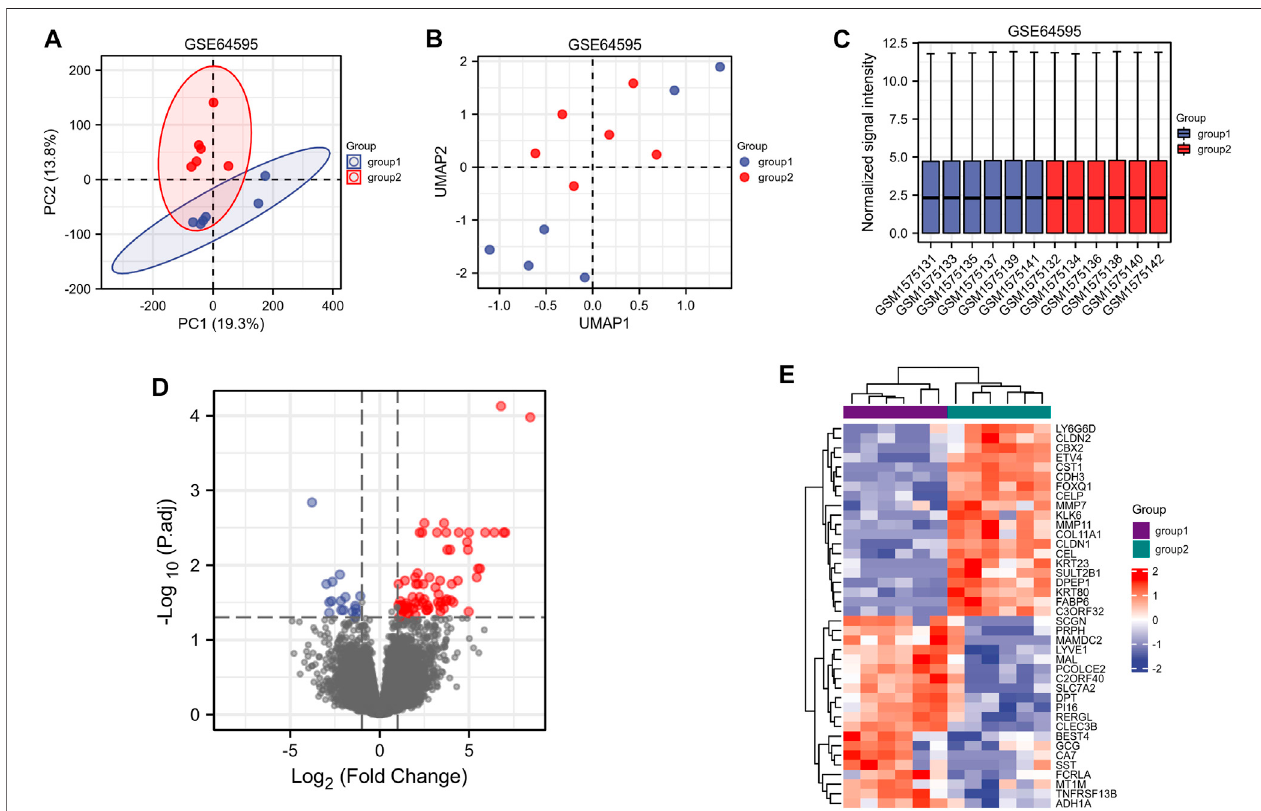
FIGURE 2 | Screening of target genes related to colorectal metastatic liver cancer (group 1 = primary colorectal cancer and group 2 = colorectal liver metastasis). (A) PCA analysis of GSE64595. (B) UMAP showed signi fi cant differences between the two groups. (C) Standardization of 12samples in GSE64595. (D) Volcanograms of differentially expressed genes in groups 1 and 2. (E) Heatmaps of differentially expressed genes between groups 1 and 2.